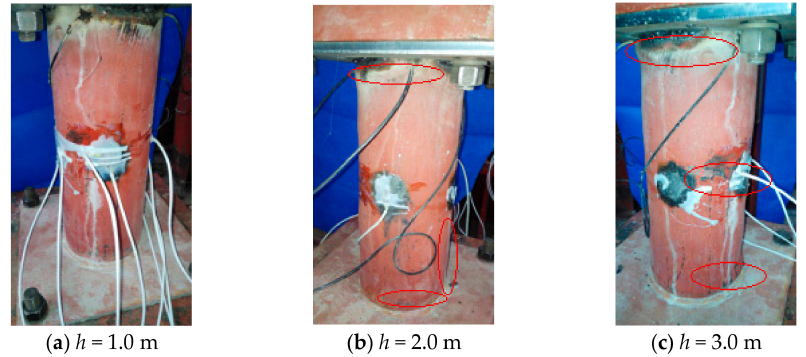
Figure 12. The failure mode of CFST with 3 mm wall